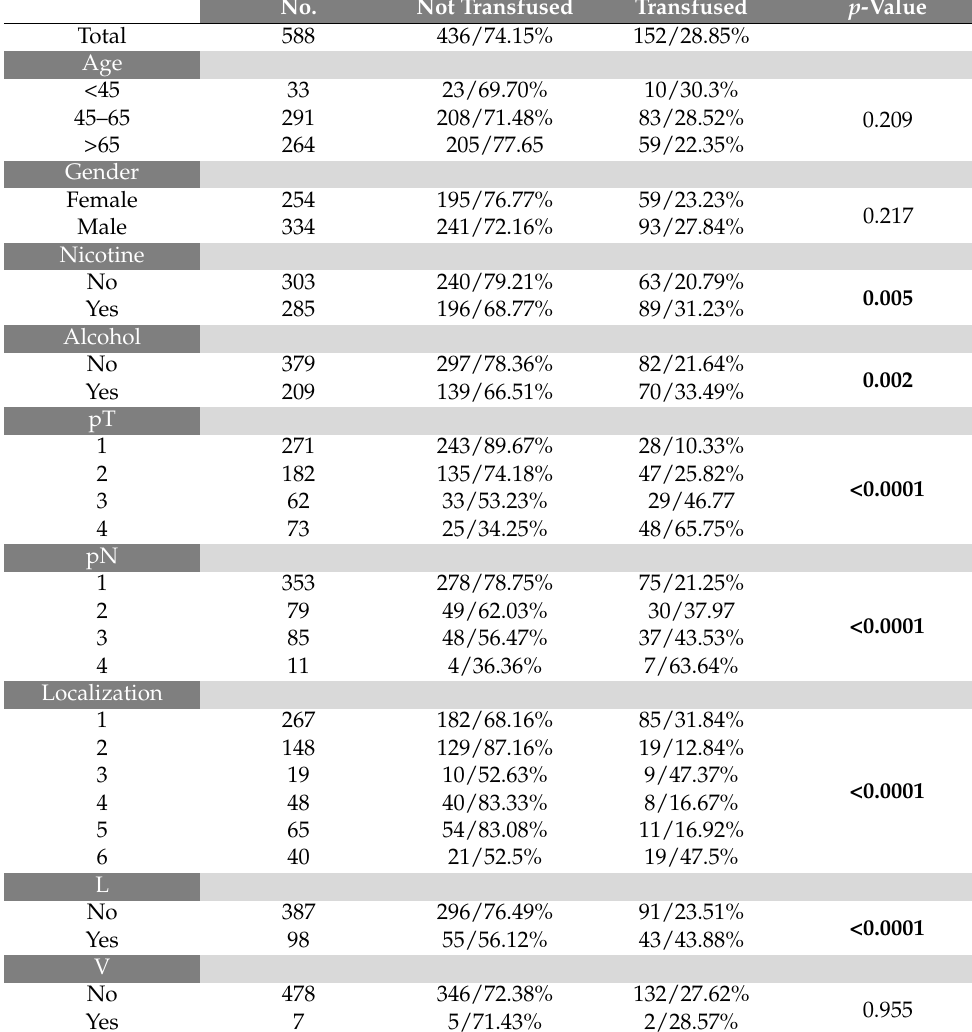
Table 1. Comparison of patient specific parameters of patients with and without blood transfusion. No. Not Transfused Transfused p -Value Total